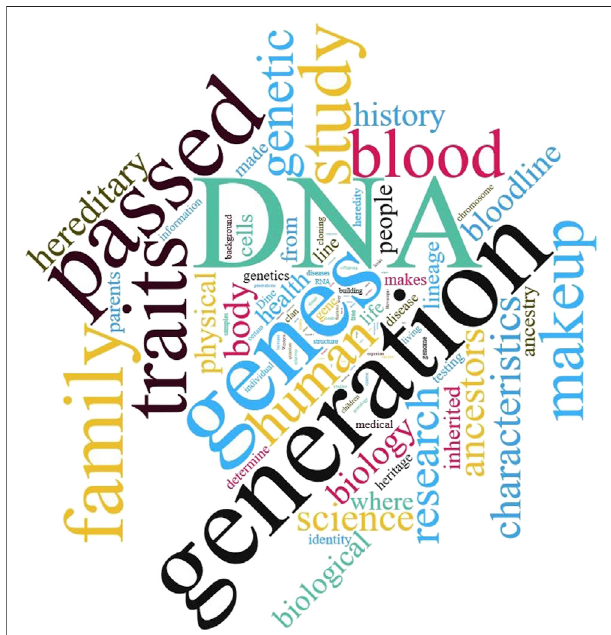
FIGURE 1 | The most commonly-used terms to describe “ genetics ” by respondents. A word cloud was generated from respondent ’ s write-in responses to the question “ What comes to mind when you hear the word genetics? ” and the fi gure displays the words with highest frequency across all responses ( n (cid:1) 615). Common everyday words such as “ a ” , “ the ” and “ and ” were excluded from the wordlist automatically by the software and was manually double checked. The words with highest frequency are equivalent to the largest words displayed in the word cloud. Colors were randomly chosen for